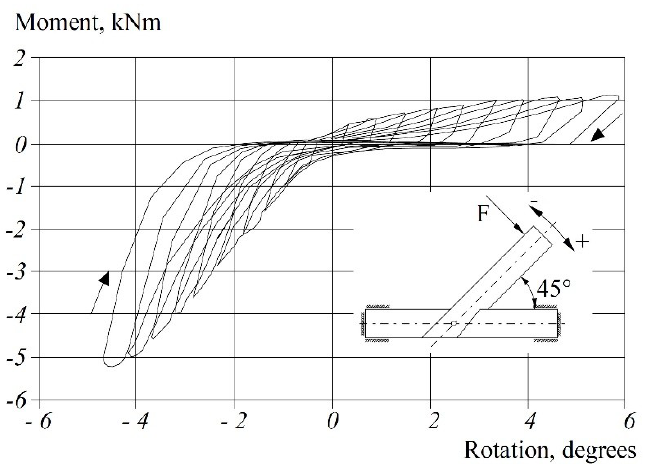
Figure 13. Example of an experimentally attained moment rotation diagram of a perfectly made halved dovetail joint [7].